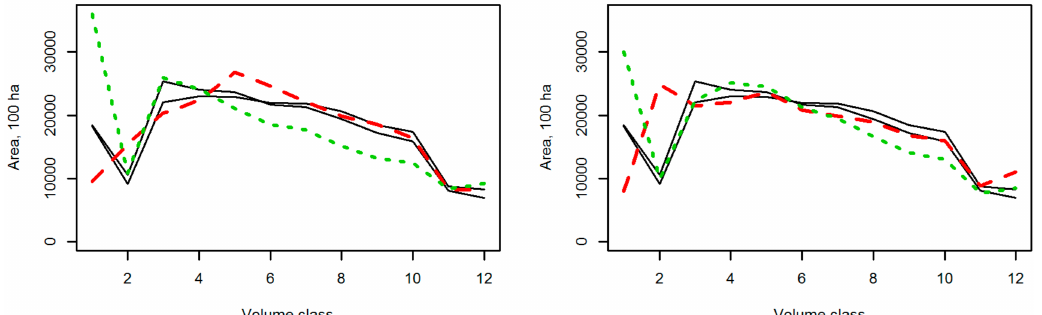
Figure 5. The development of the volume class distribution in one simulation step. The black solid lines indicate the class distribution observed in the NFI10 and NFI11 data. The red and green broken lines represent predictions based on forecasting from NFI10 data or backcasting from the NFI11 data, respectively, with the transition probabilities derived from the permanent ( left ) and temporary ( right ) plots for pairwise